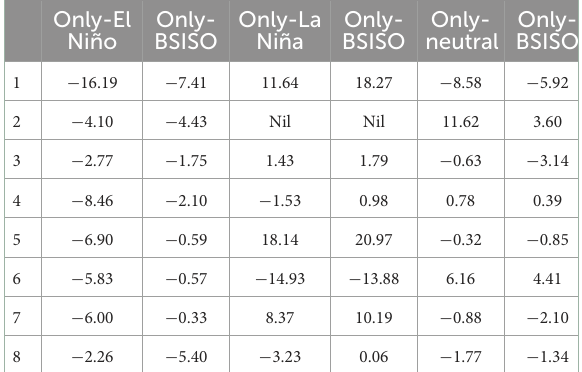
TABLE 5 Percent changes in mean rainfall anomalies between composites of only-BSISO and only-ENSO and the combined composites over NE